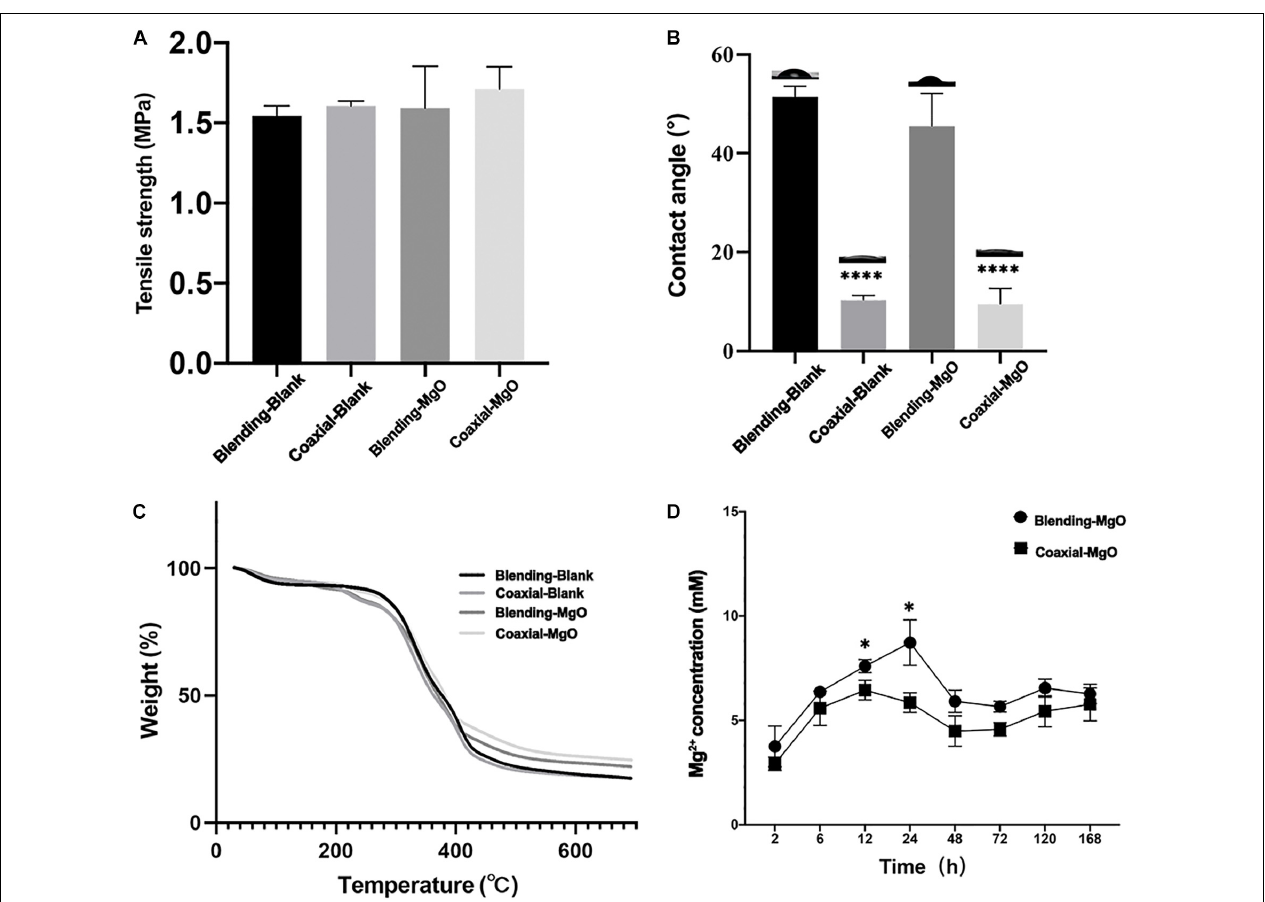
FIGURE 2 | Chemical, physical, and mechanical properties of the electrospun membranes. (A) Tensile strength of Blending-Blank, Coaxial-Blank, Blending-MgO, and Coaxial-MgO, respectively. (B) Contact angles of the electrospun membranes. (C) Thermal stabilities of PCL/gelatin nanocellulose membranes tested by TGA. (D) Mg 2 + release of Blending-MgO and Coaxial-MgO in PBS from 0 to 168